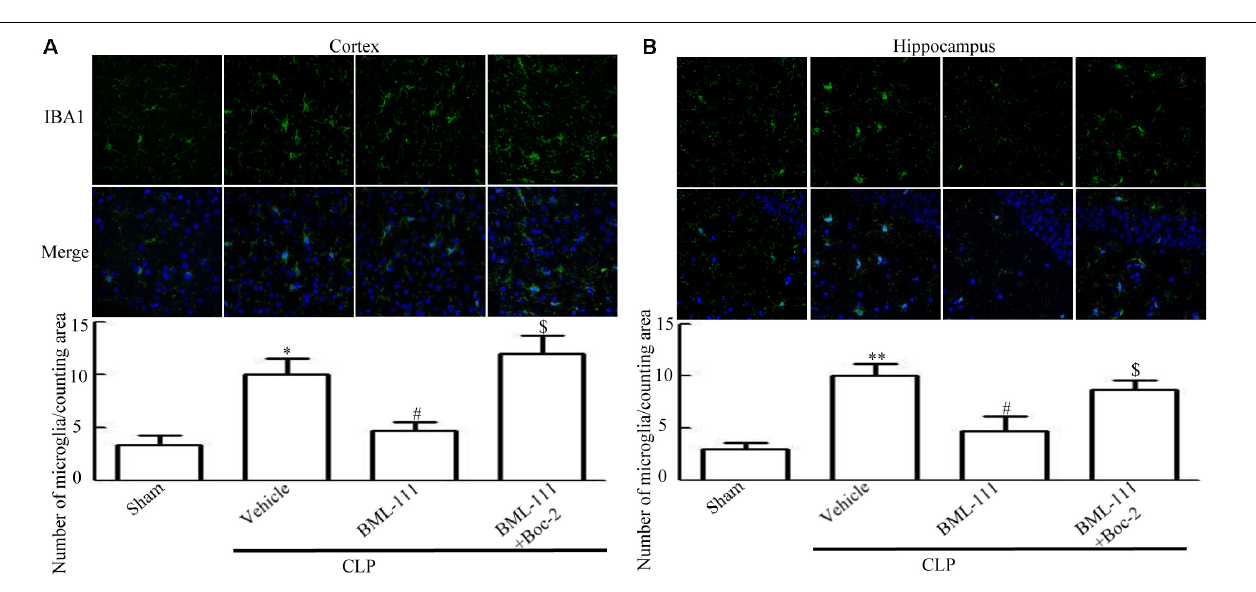
FIGURE 5 | BML-111 treatment reduces the activation of microglias in CLP mice. (A,B) Activated-microglia cells were significantly increased in the CLP + vehicle group compared with the sham group. BML-111 treatment down-regulated the activated cells compared with the CLP + vehicle group, and Boc-2 reduced the effects of BML-111. Scale bars indicate 50 µ m ( n = 3 surviving mice per group per experiment). Data were shown as the means ± SEM. ∗ P < 0.05, ∗∗ P < 0.01 represent CLP + Vehicle vs. Sham, # P < 0.05 represents CLP + BML-111 vs. CLP + Vehicle, $ P < 0.05 represents CLP + BML-111 + Boc-2 vs. CLP +